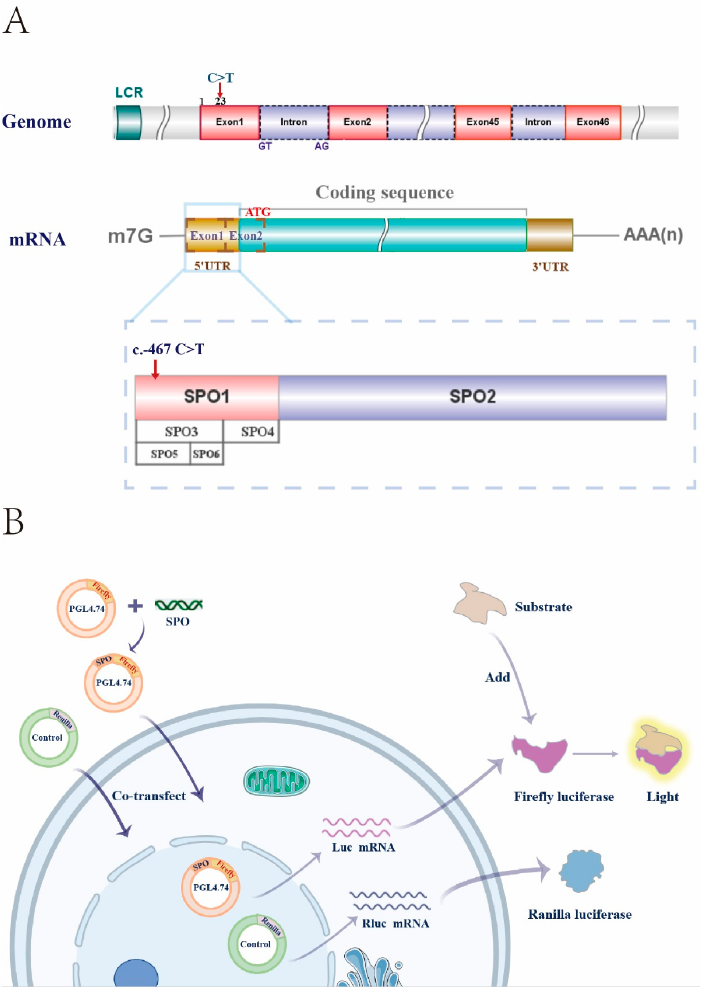
Figure 4. Schematic of principle . ( A ) Schematic representation of the NIPBL 5’ UTR engineering strategy. ( B ) The schematic of Dual-Luciferase reporter gene assay system.